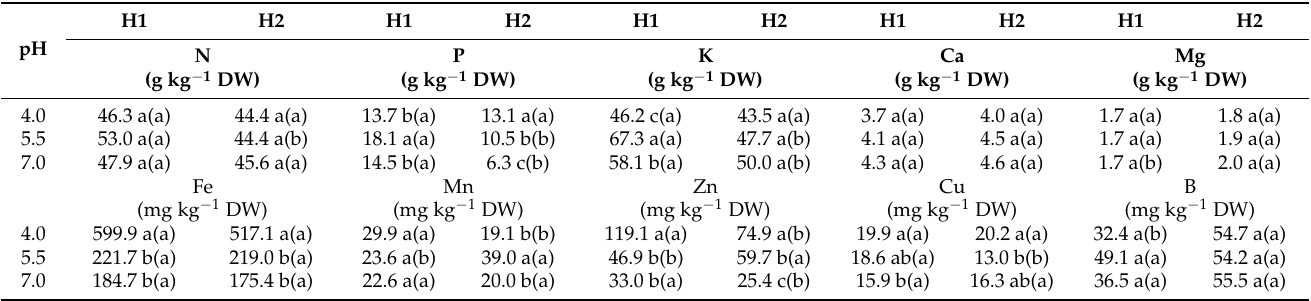
Means in columns followed by the same letter do not differ significantly ( p ≤ 0.05, L.S.D. test). Means in the same row followed by the same letter in parenthesis do not differ significantly ( p ≤ 0.05, T -test). DW: dry weight.